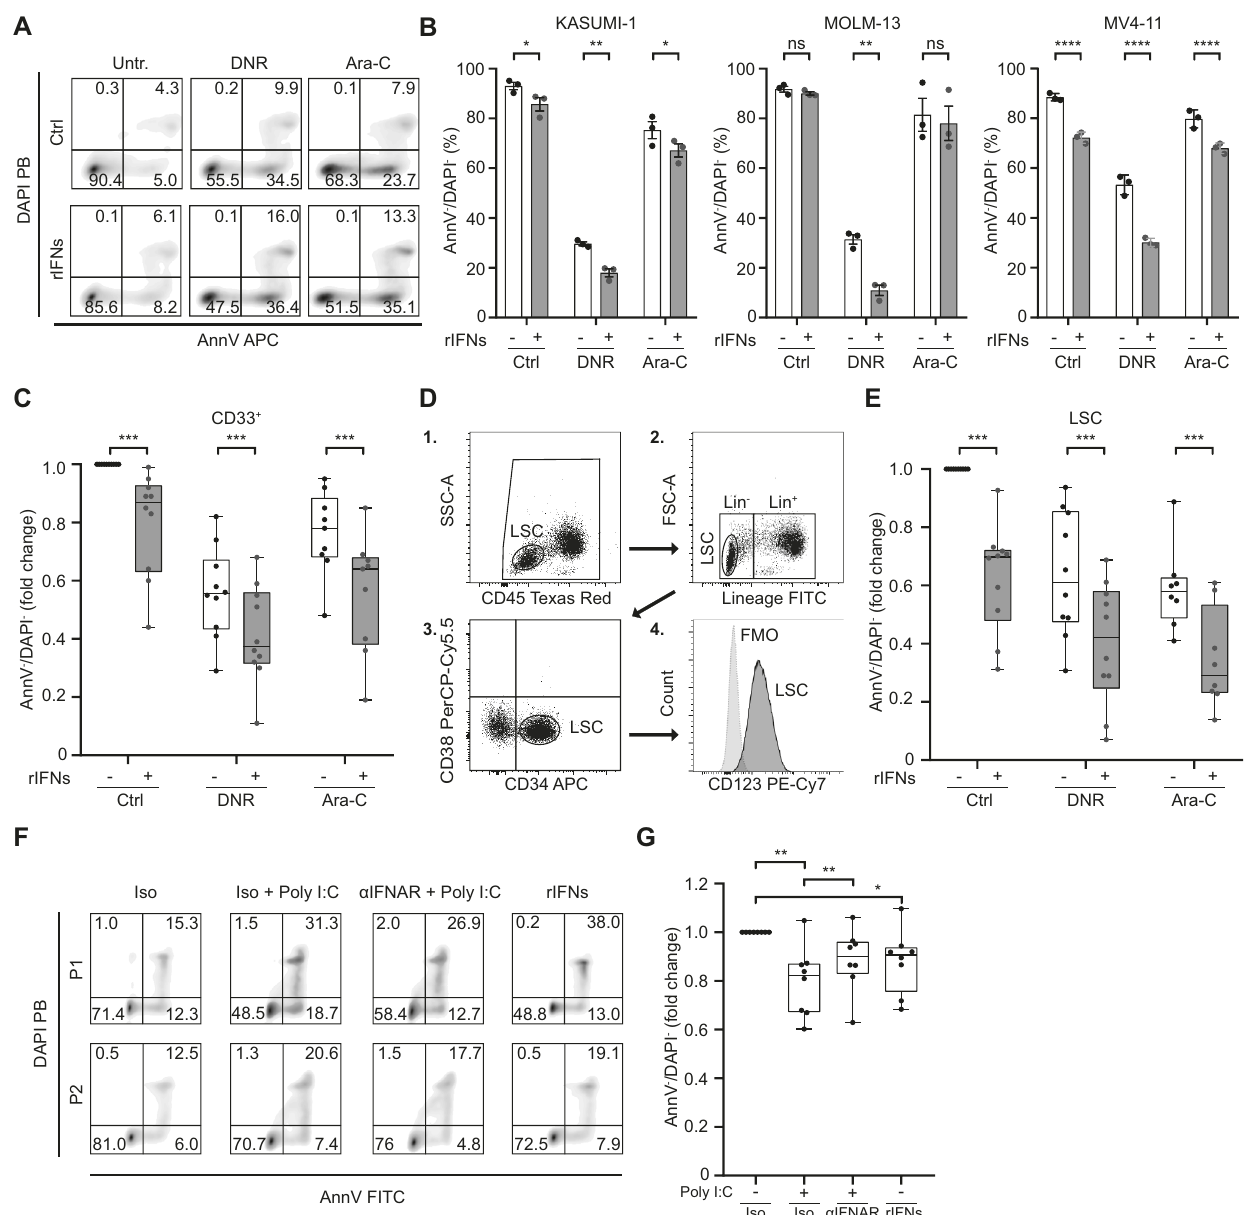
Fig. 3 Recombinant type I IFN mediates direct cytostatic and cytotoxic activity on AML blasts and leukemic stem cells. A , B Representative dot plots A and percentages B of viable (Annexin V − /DAPI − ) KASUMI-1, MOLM-13 and MV4 – 11 cells after daunorubicin (DNR) and cytarabine (Ara-C) 24 h treatment with optional recombinant IFN- α plus IFN- β (rIFNs) (500 pg/mL) 3 days pre-incubation, as determined by fl ow cytometry. Data are reported as means ± SD plus individual data points. * p < 0.05; ** p < 0.01, **** p < 0.0001, ns: not signi fi cant (paired t-test). C Relative viability of CD33 + leukemic blasts from 10 AML patients (Study Cohort 3) after DNR or Ara-C treatment with optional 3 days pre- incubation with rIFNs (500 pg/mL). Data are reported as means, quartiles and extremes plus individual data points. *** p < 0.001 (paired t-test). D Gating strategy for determination of leukemic stem cells (LSCs) in AML patient PBMCs using fl ow cytometry. E Relative viability of LSCs isolated from 10 AML patients (Study Cohort 3) after DNR or Ara-C treatment with optional 3 days pre-incubation with rIFNs (500 pg/mL). Data are reported as means, quartiles and extremes plus individual data points. *** p < 0.001 (paired t-test). F Relative viability of CD33 + leukemic blasts from 8 AML patients (Study Cohort 3) 96 h upon exposure to polyI:C in the optional presence of an IFNAR1 blocking antibody, or rIFNs, Data are reported as means, quartiles and extremes plus individual data points. * p < 0.05, ** p < 0.01 (paired